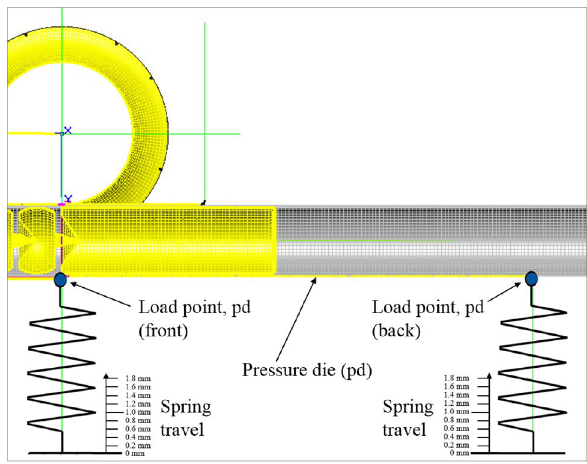
Fig. 21 Spring travel at the pressure die